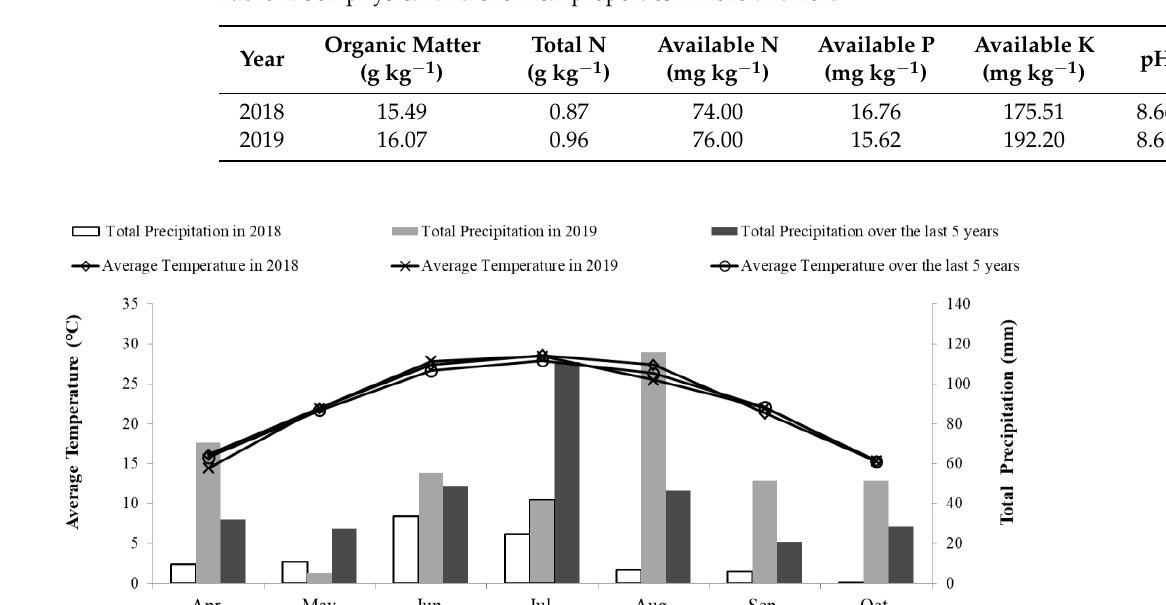
Figure 1. Meteorological data during the cotton growth period of the field experiment from May to October on the Anyang of Henan.